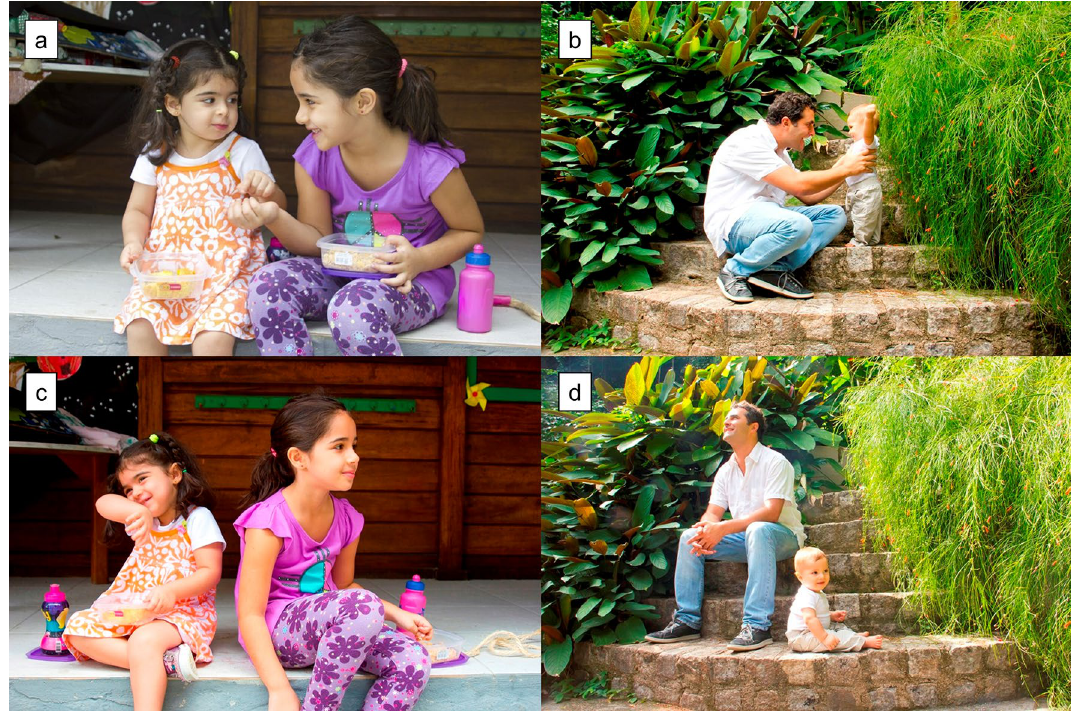
Figure 1. Examples of bonding and control pictures. Note Examples of bonding pictures ( a and b ) and control pictures ( c and d ). For more details about the complete picture catalogue and its standardization, see Silva et al. 3 . All pictures from the catalogue are property of the present research group, and their reproduction is authorized for scientific purposes